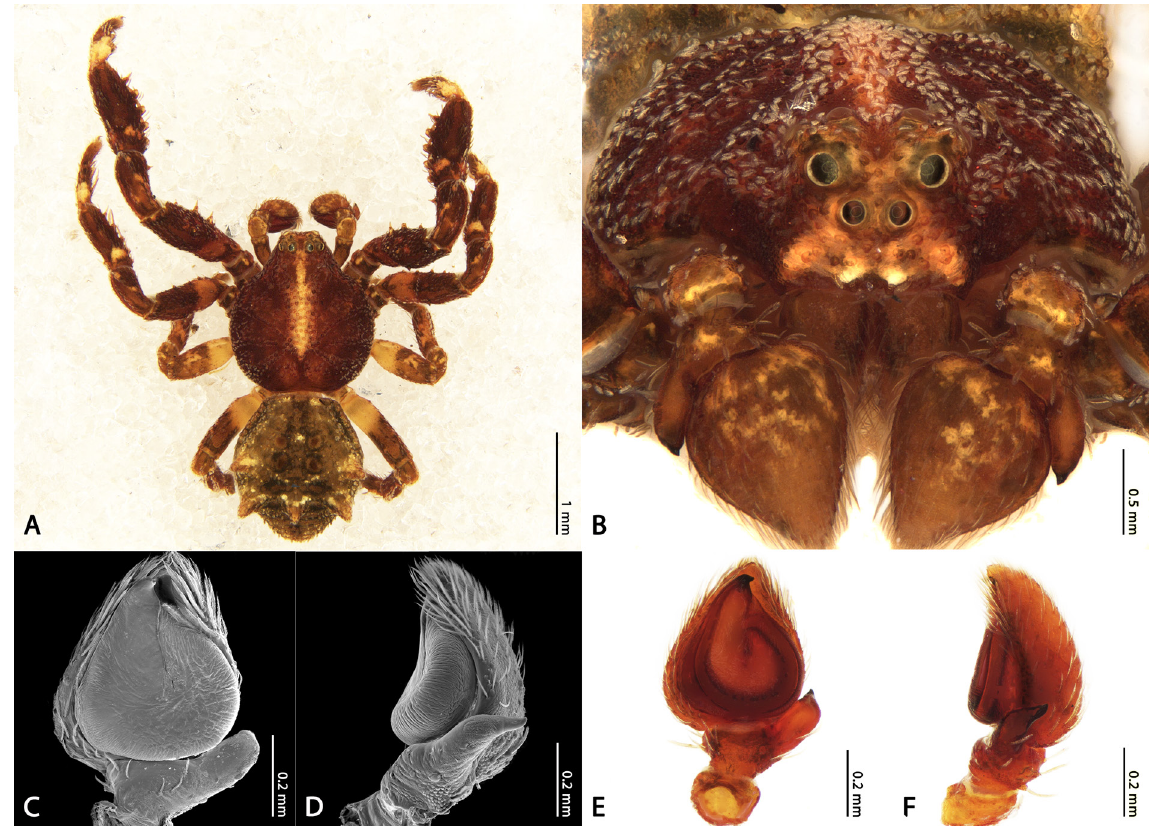
Fig. 5. Male of Kryptochroma hilaris Machado & Teixeira gen. et sp. nov. (MPEG 13239). A. Habitus, dorsal view. B . Front. C–F . Left male palp. C, E . Ventral view. D, F . Retrolateral